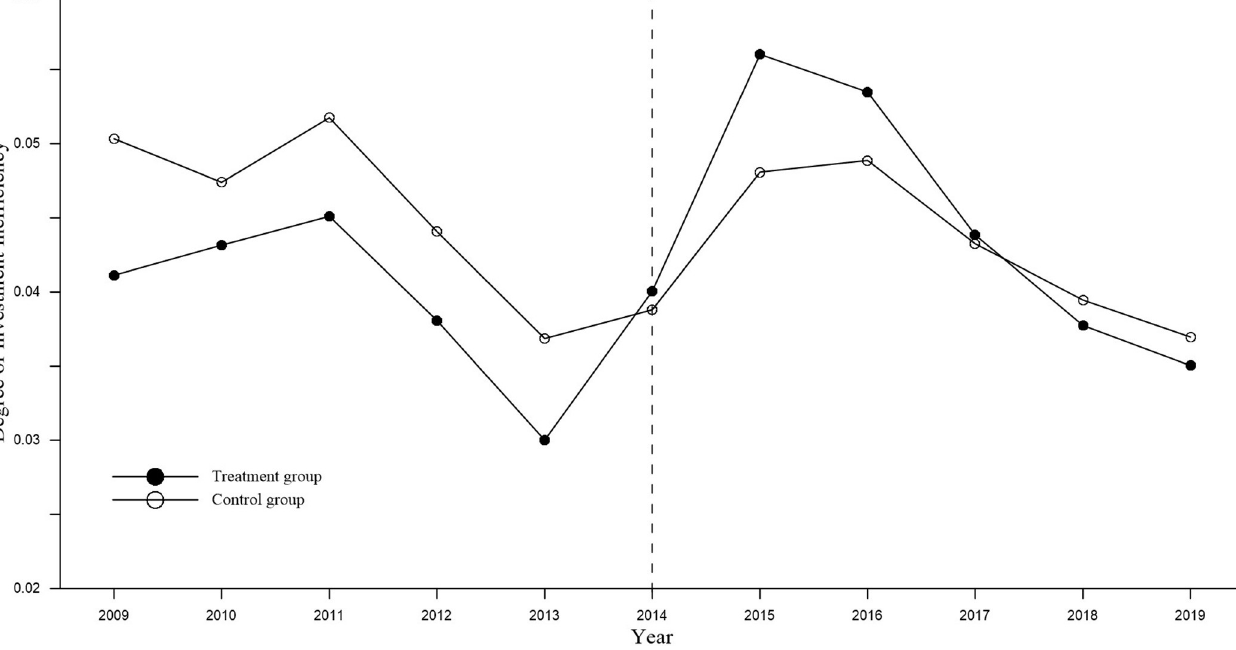
PLOS ONE | https://doi.org/10.1371/journal.pone.0274336 September 22,